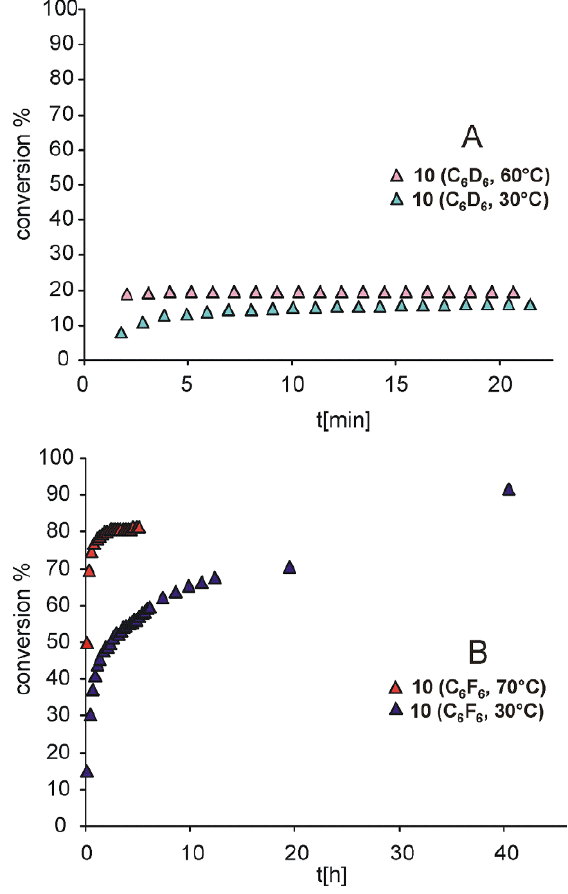
Figure 4. Kinetic profiles of RCM of 10 0.1 M and 5% catalyst